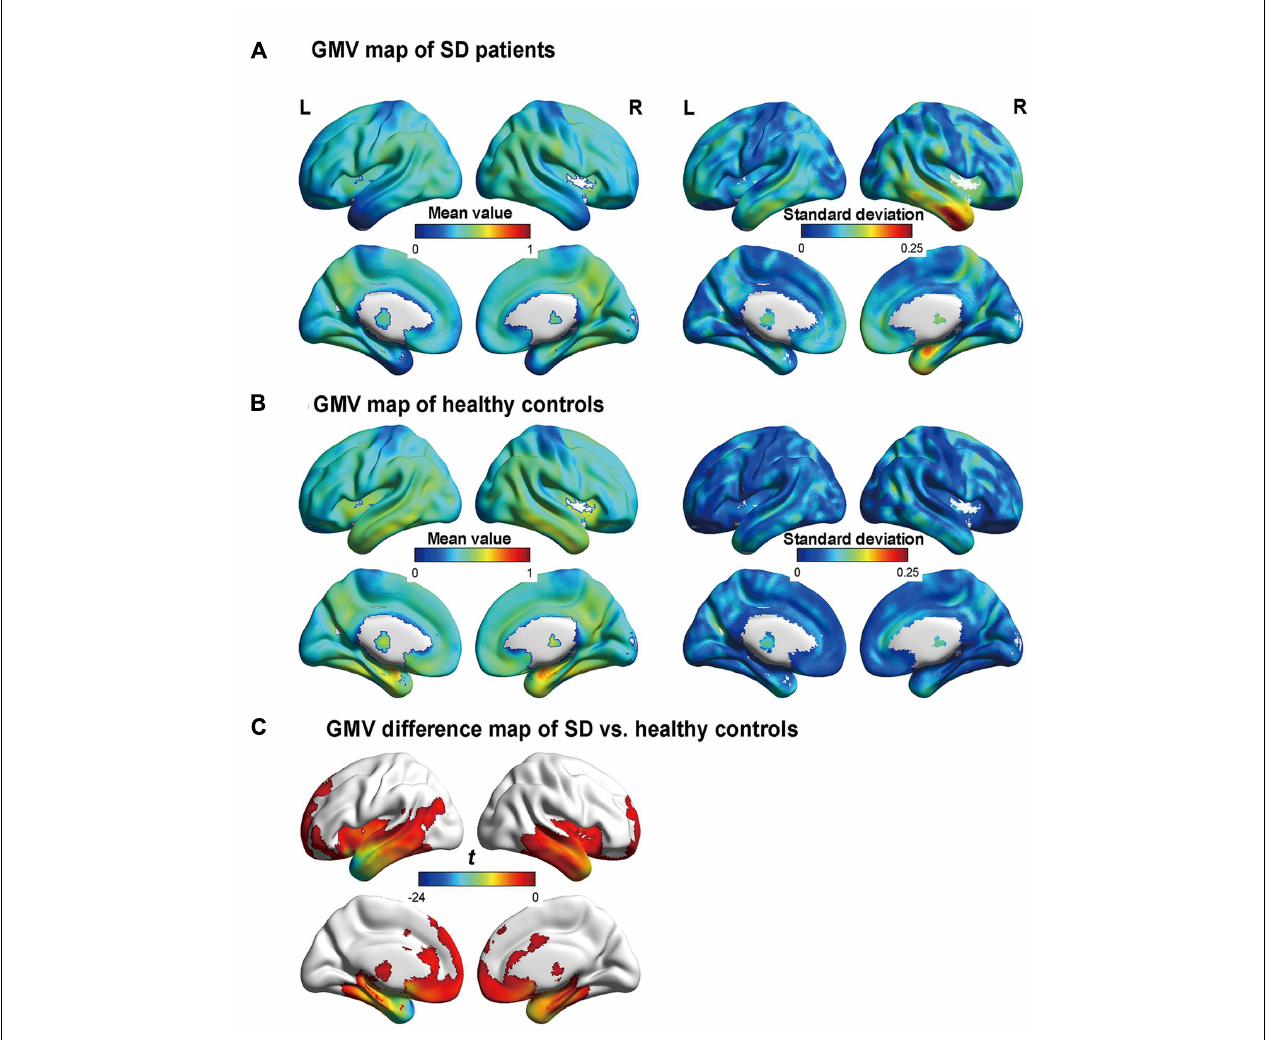
FIGURE 1 | Gray matter volume (GMV) maps of the participants. (A) and (B) are the GMV maps of the SD patients and healthy controls, respectively. The value of each voxel is the mean value (i.e., the left column) or the standard deviation (i.e., the right column) of the GMV. (C) The regions with significant differences in GMV between the semantic dementia (SD) patients and healthy controls, with AlphaSim-corrected p < 0.05 (individual voxel: p < 0.05; cluster size > 2885 voxels). More negative values denote more severe